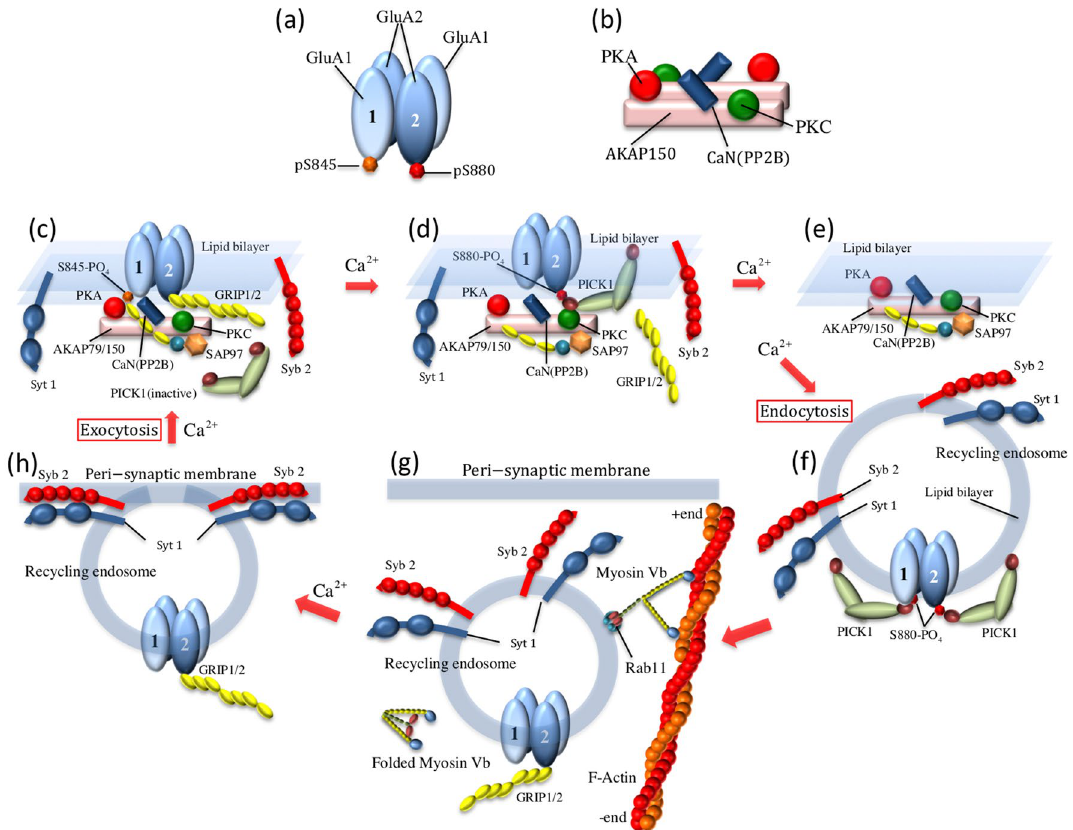
Figure 1. AMPAR trafficking model at hippocampal postsynaptic neurons. ( a ) AMPAR which consists of two GluA1 (GluR1) and two GluA2 (GluR2) subunits is the most predominant AMPAR subtype in hippocampal neurons 4 . The serine-845 site (S845) of GluA1 is phosphorylated and dephosphorylated by protein kinase A (PKA) 35 and protein phosphatase 2B (PP2B, or Calcineurin, CaN) 36 , respectively. The serine-880 site (S880) of GluA2 is phosphorylated and dephosphorylated by protein kinase C (PKC) 37 and protein phosphatase 2 (PP2A), respectively. ( b ) A-kinase anchoring protein 150 (AKAP150) 34,43,44 is an anchoring protein that organizes PKA, PP2B, and PKC for phosphoregulation of AMPARs at the synaptic membrane, and thus acts as the AKAP signaling complex. The AKAP signaling complex forms the dimer as shown in ( b ) (though, for simplification, not shown in ( d – e )). ( c – h ) Experimentally characterized elementary processes involved in the AMPAR trafficking cycle at a hippocampal postsynaptic neuron. ( c ) A model of tethering the GluA1 and GluA2 subunits to the AKAP150 signaling complex at the synaptic membrane through SAP97 and GRIP1, respectively 34,43,44 . ( d ) A model of phosphorylation and dephosphorylation reactions of the AMPAR due to Ca 2+ signaling. Dephosphorylation of the S845 site of GluA1 is caused by PP2B 36 , and SAP97 dissociates from GluA1. The S880 site of GluA2 is phosphorylated by PKC, and PICK1 binds to the GluA2 subunit instead of GRIP1 37,38 . ( e , f ) An endocytic model for synaptic vesicles containing AMPAR mediated by the calcium-sensor PICK1 37,38,47 . ( g ) Active transport of the recycling endosomes by molecular motor myosin V b40–42 . In the recycling endosome, PP2A causes the dephosphorylation of S880 of GluA2, and GRIP1 instead of PICK1 binds to GluA2 46 . ( h ) An exocytic model of the recycling endosome triggered by Ca 2+ -sensor synaptic vesicle protein synaptotagmin 1 (Syt1) together with synaptotagmin 7 (not shown) and synaptobrevin-2 (Syb2)/VAMP2, complexin (not shown), amongst others 22,23,48–50,61